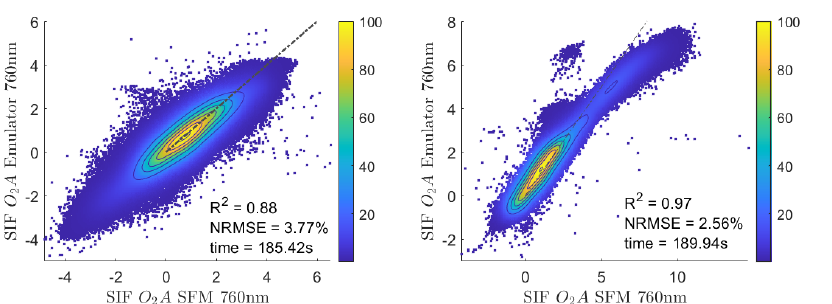
Figure 10. Scatter plot of the SFM SIF map retrieved at 760 nm and the corresponding map emulated with the developed KRR model for the entire flight line L2 ( left ) and flight line L4 ( right ). The x-axis represents the SIF values retrieved with the SFM while the y-axis shows the SIF values estimated by the emulator. The dashed line represents the 1:1-line. Units are in (mW m − 2 sr − 1 nm − 1